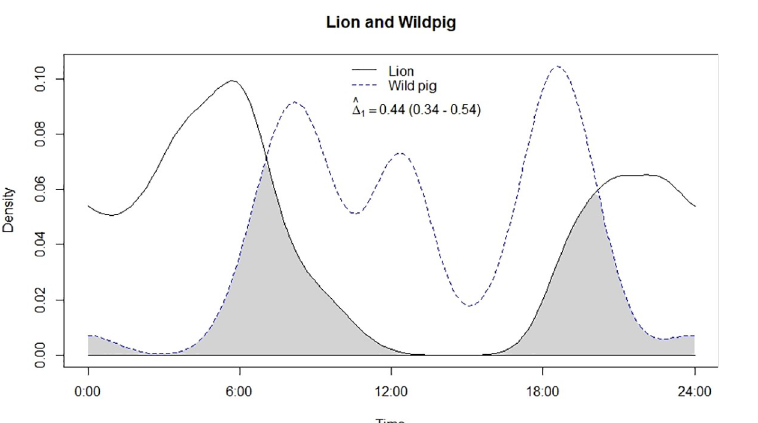
Fig 8. Temporal overlap between lion and wild